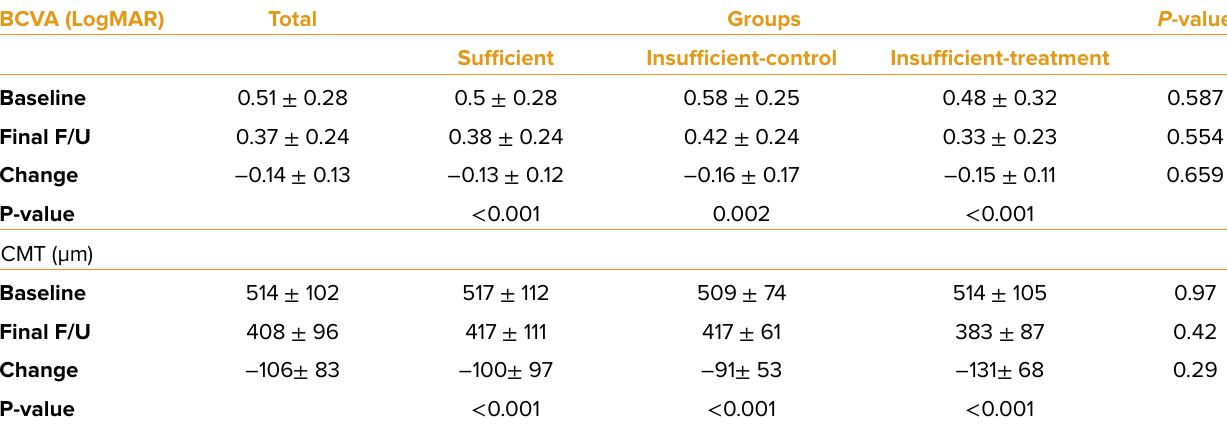
Table 2. Best-corrected visual acuity changes after three intravitreal bevacizumab injections BCVA (LogMAR) Total Groups P -value